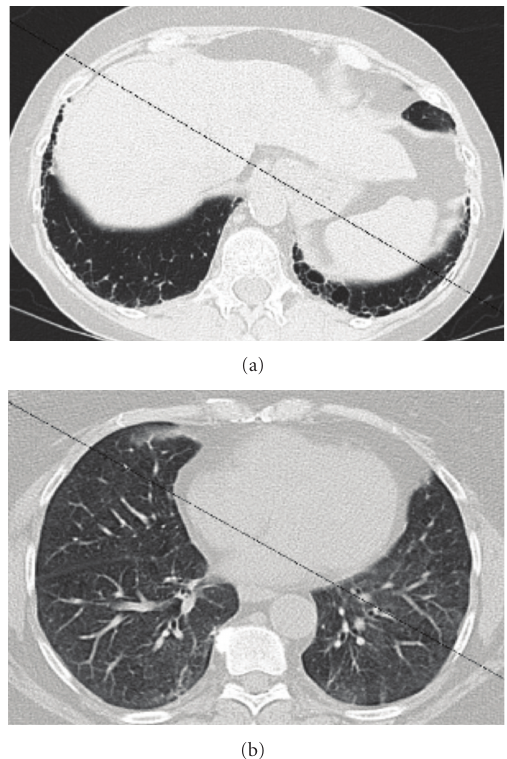
Figure 1: HRCT demonstrating predominantly reticular findings (a) as well as ground glass changes